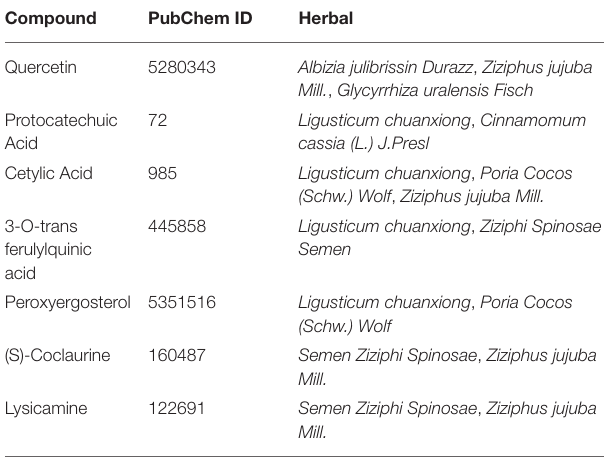
TABLE 1 | The information of shared